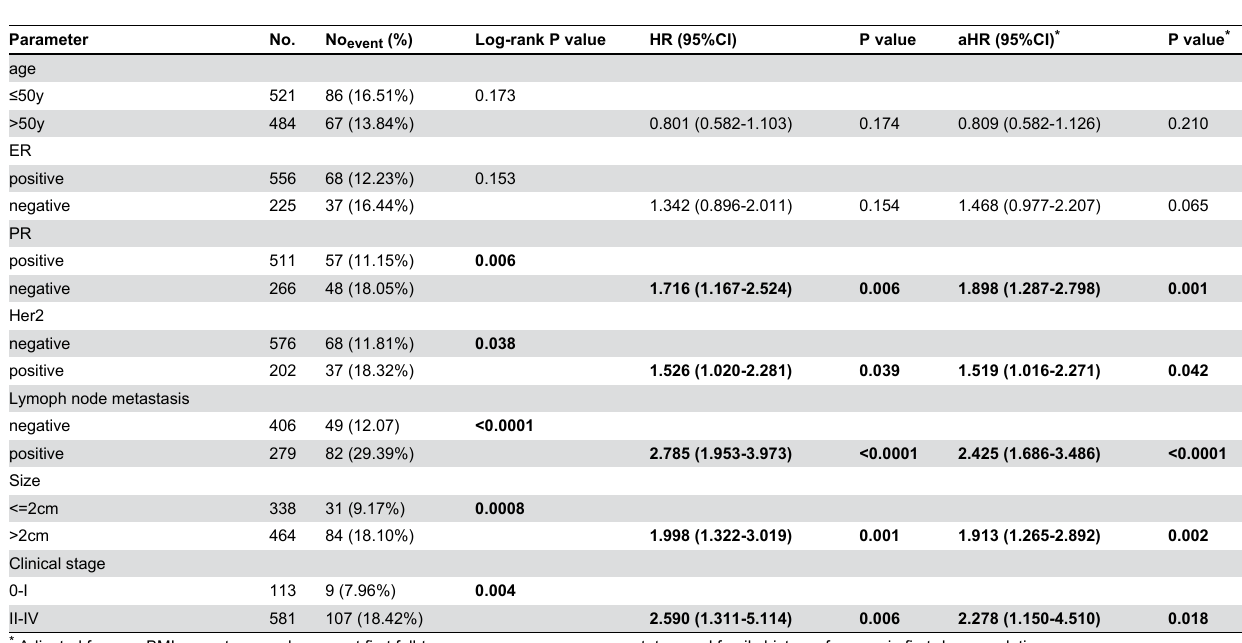
Table 4. Association analysis of the clinicopathological parameters in relation to event-free survival of breast cancer patients